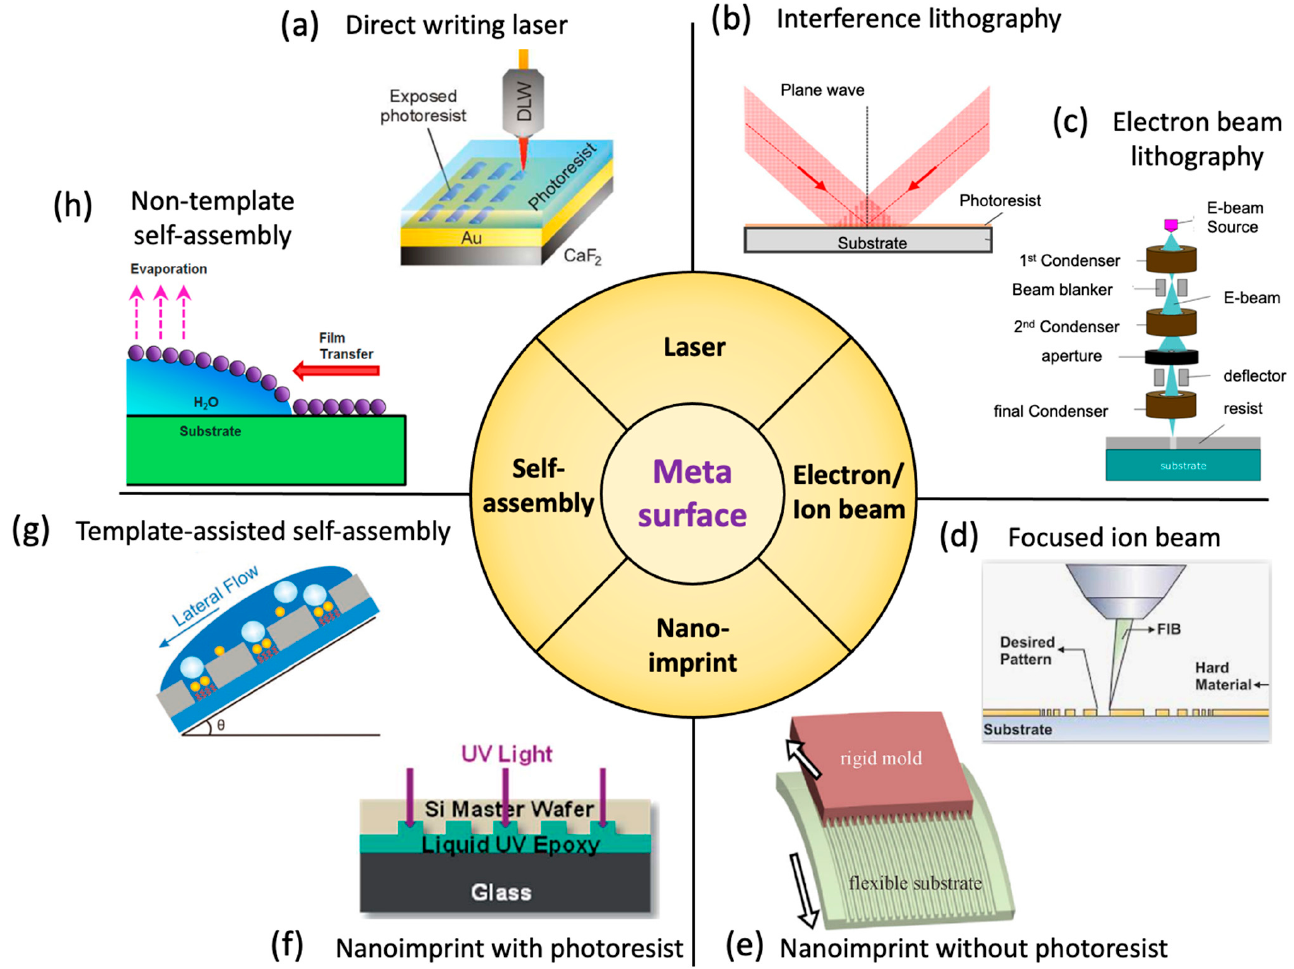
Figure 11. Existing methods for fabricating metamaterials. Schematic of the ( a ) Direct writing laser. Reprinted with permission from Ref. [106]. Copyright 2015 American Chemical Society. ( b ) Interference lithography. Reprinted from Refs. [106,107]. ( c ) Electron beam lithography. Reprinted from Ref. [108]. ( d ) Focused ion beam. Reprinted from Ref. [109]. ( e ) Nanoimprint without photoresist. Reprinted from Ref. [110]. ( f ) Nanoimprint with photoresist. Reprinted with permission from Ref. [76]. Copyright 2014 The Royal Society of Chemistry. ( g ) Template-assisted self-assembly. Reprinted from Ref. [111]. ( h ) Non-template self-assembly. Reprinted with permission from Ref. [112]. Copyright 2013 WILEY-VCH Verlag GmbH & Co. KGaA.